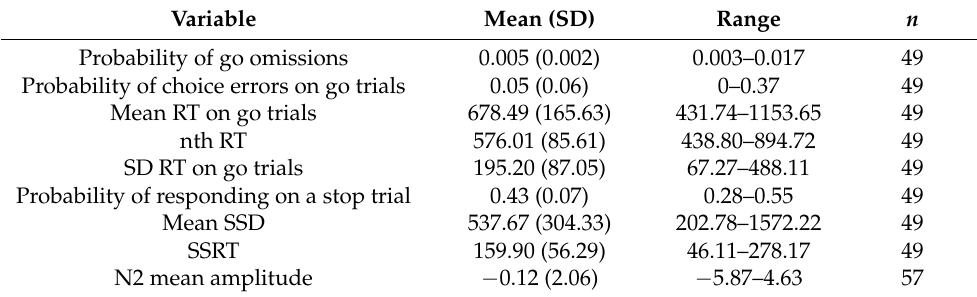
Table 1. Descriptive Statistics of SST Measures at Age 17